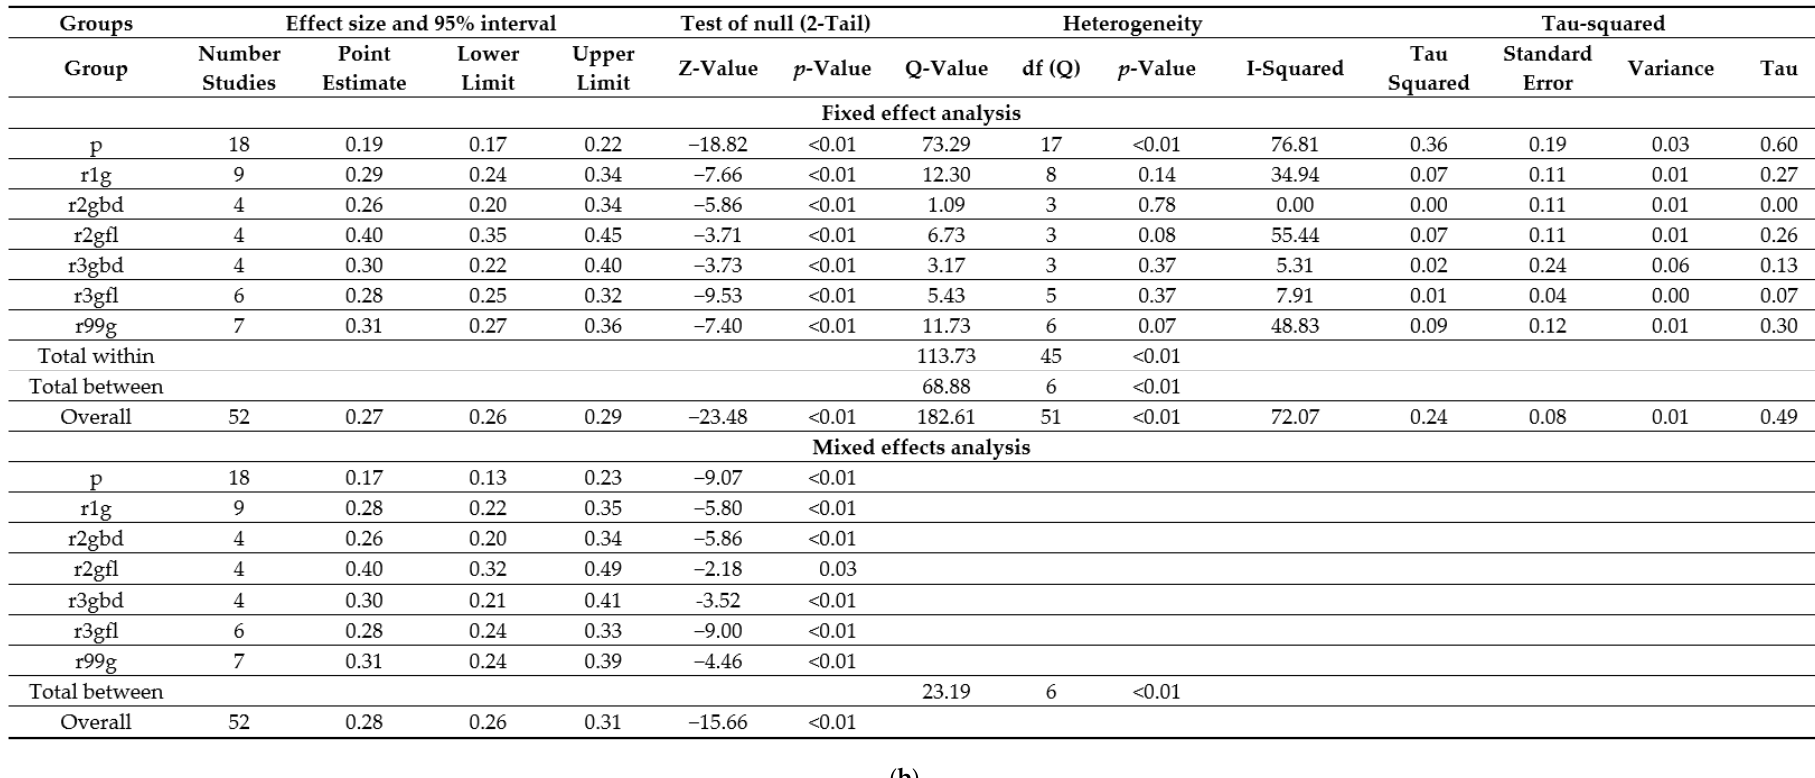
Figure 6. Analysis results for high severity disease and any titre inhibitor patients of the 22 relevant studies: Forest plot ( a ), Basic statistics ( b ). p = plasma-derived; r1g = recombinant 1, generation full length; r2gfl = recombinant 2, generation full-length; r2gbd = recombinant 2, generation B domain deleted; 3gfl = recombinant 3, generation full-length; r3gbd = recombinant 3, generation B domain deleted; rg99 = recombinant not further specified.